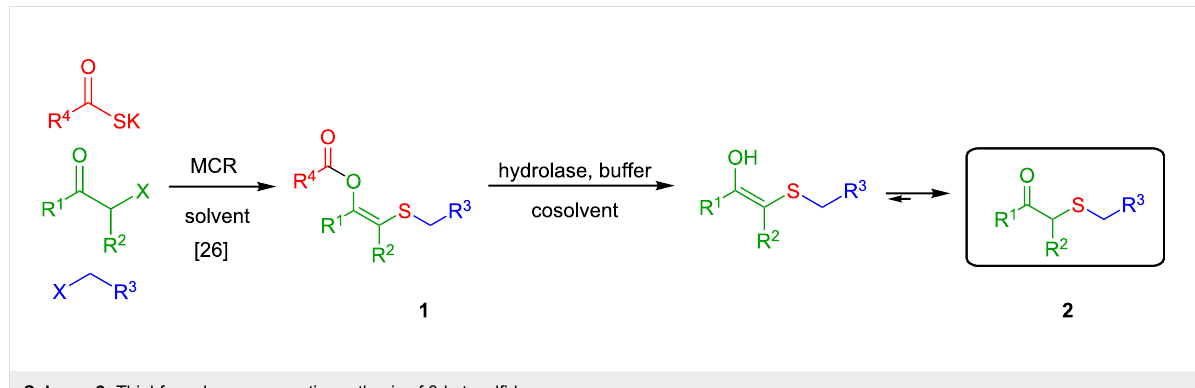
Scheme 2: Thiol-free chemoenzymatic synthesis of β